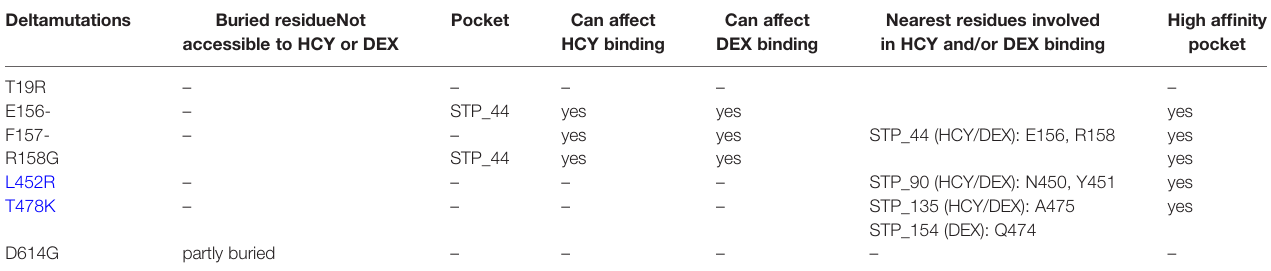
TABLE 5 | S1 mutations in Delta variant (B.1.617.2) of SARS-CoV-2 and their accessibility to cortisol (HCY) and dexamethasone (DEX)